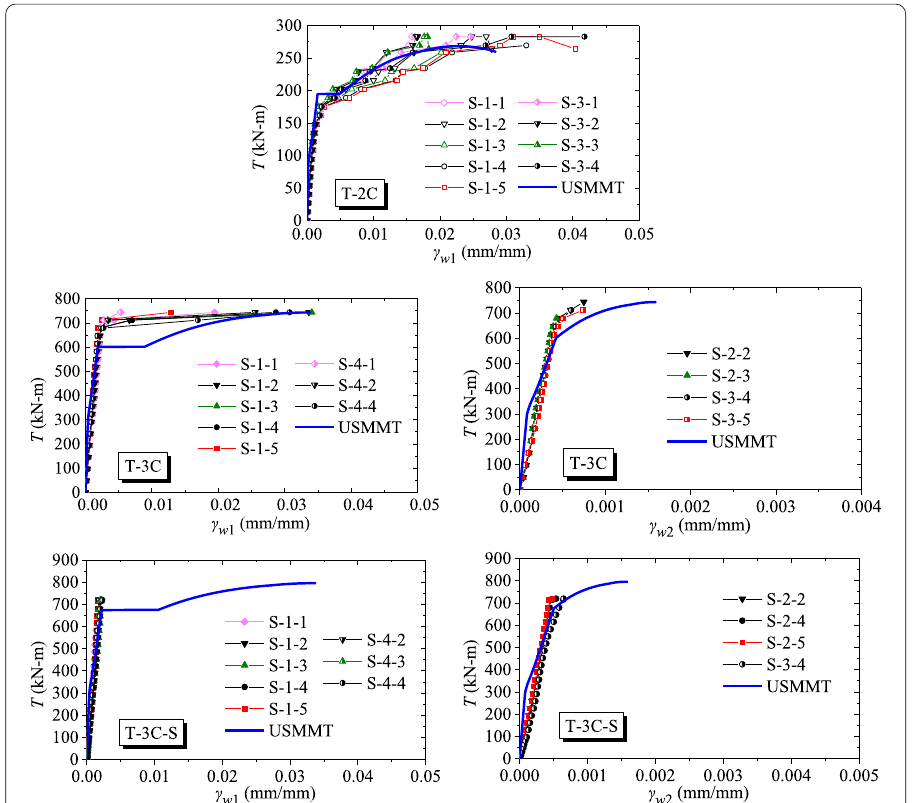
Fig. 7 Comparisons of the shear strains in concrete slabs and CSWs of the specimens under pure torsion between the experimental results and the calculated results from the